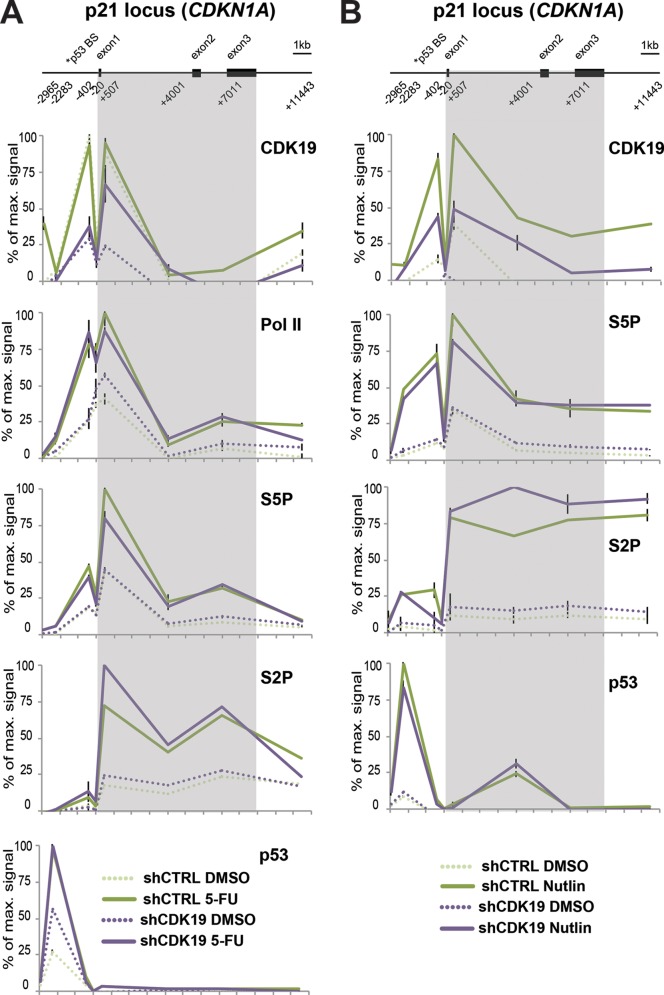
CDK19 associates with p53 target gene CDKN1A; knockdown does not notably affect Pol II or p53 occupancy. (A) ChIP data comparing DMSO- and 5-FU-treated cells. A scheme of the p21 locus is shown at the top. Numbers indicate primer positions used for gene tiling. Positions are given as the distance from the transcription start site. Proteins probed by ChIP are shown at the upper right of each plot. The key for each experiment is shown at the bottom. (B) ChIP data comparing DMSO- and nutlin-treated cells (6 h treatment). The scheme of the p21 locus is shown at the top. Numbers indicate primer positions used for gene tiling. Positions are given as the distance from the transcription start site. Proteins probed by ChIP are shown at the upper right of each plot. The key for each experiment is shown at bottom.